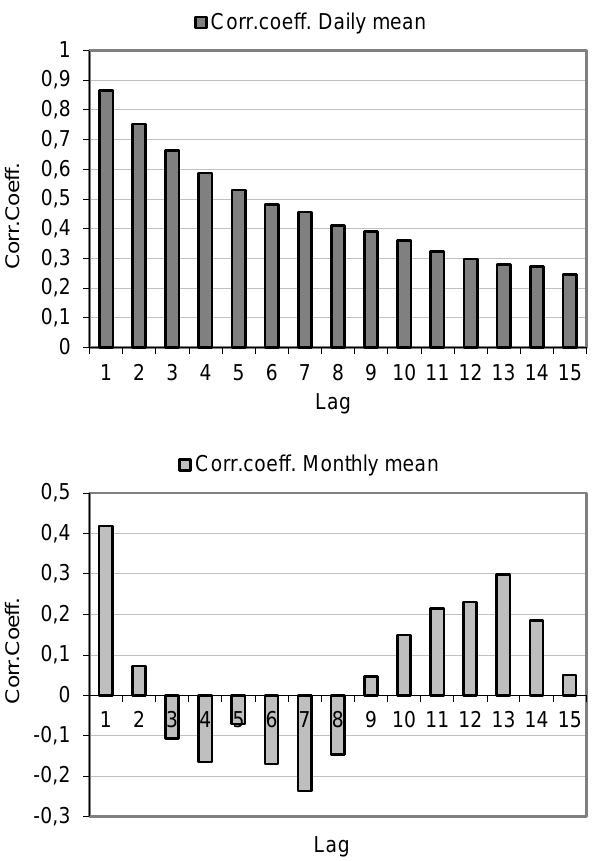
Fig. 8. Autocorrelation of turbidity at a daily (top diagram) and on a monthly (bottom diagram) basis, gauging station L¨arjeholm